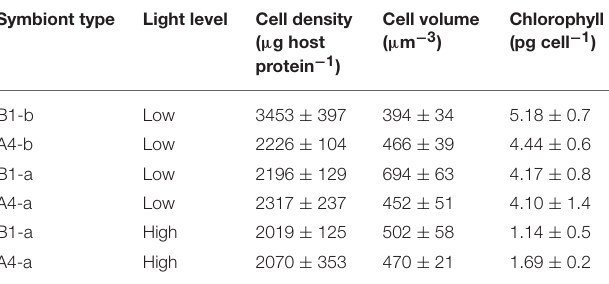
TABLE 2 | Symbiont